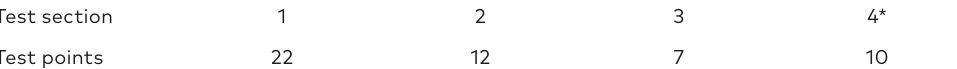
Table 2. Statistical analysis and test